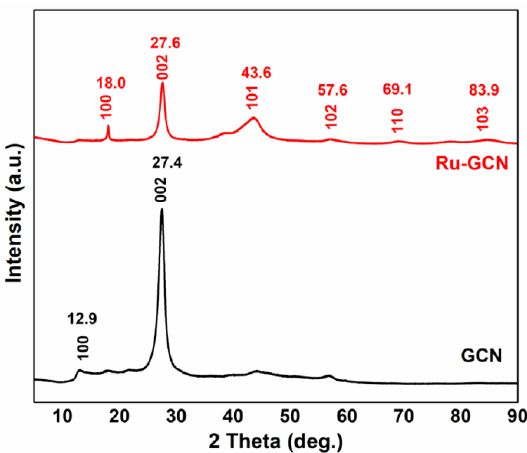
Figure 2. Powder X-ray diffraction (PXRD) patterns of GCN and Ru-GCN. GCN and Ru-GCN have been analyzed using Fourier-transform infrared spectroscopy (FTIR). It shows the presence of chemical functionality in the material. The FTIR spectra of GCN and Ru-GCN are shown in the Figure 3. The broad absorption band in the range 3000 to 3400 cm − 1 was observed because of N–H stretching vibrations. The peaks at 1390 cm − 1 indicates the C–N stretching vibration, while 1620 cm − 1 corresponds to C=N stretching vibration of the aromatic triazine ring system. The absorption band 798 cm − 1 corresponds to the triazine ring system in the GCN material. In case of Ru-GCN material, it is found that the broadness and intensity of the peak which indicates N–H stretching vibration are decreased strongly. Hence, it can be contemplated that it is due to the Ru metal interaction with GCN material. Moreover, the intensity of the peak 1530 cm − 1 also decreases to a great extent after formation of Ru-GCN nanocomposite from GCN.